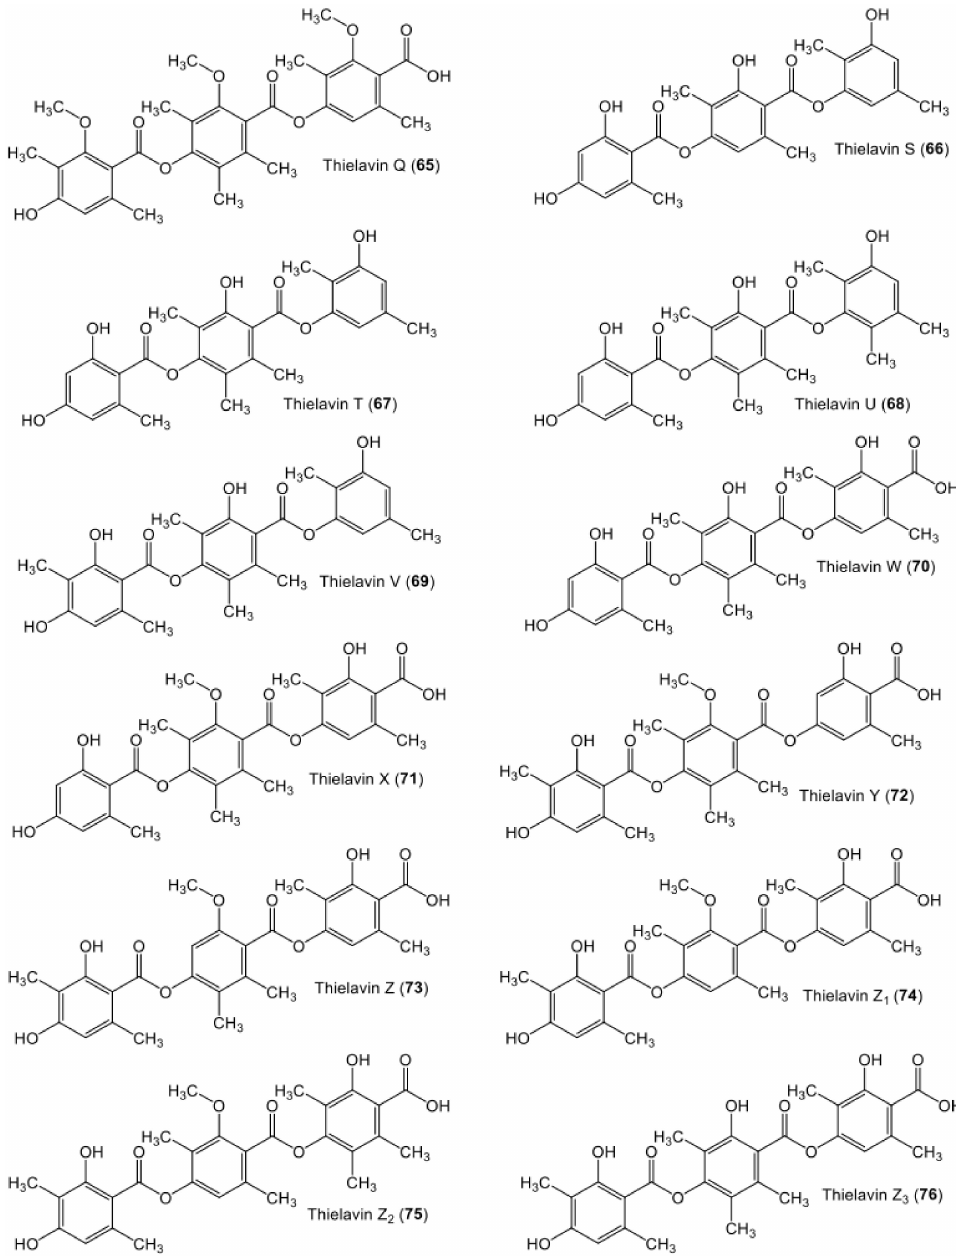
Figure 10. Chemical structures of tri-depsides 65 – 76